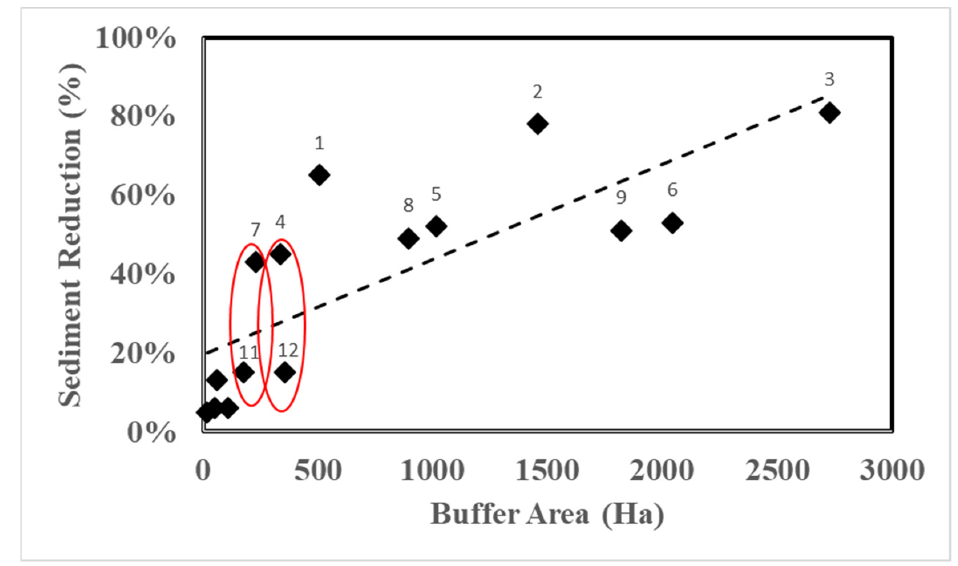
Figure 11. Relative sediment reduction (%) from baseline conditions for riparian buffers in function of their surface area. The numbers refer to scenario ID from Table 4. The two red circles highlight two examples in which a similar riparian buffer area size leads to a large difference in sediment reduction.